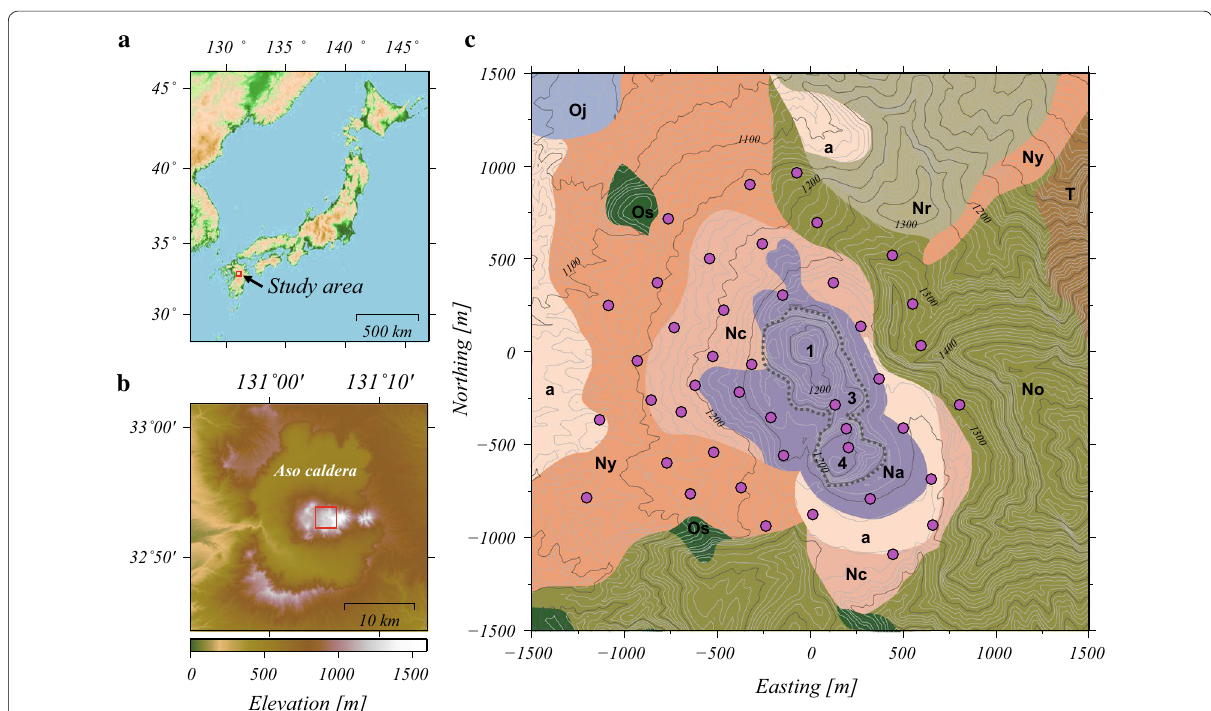
Fig. 1 Location maps of Aso volcano and the AMT survey area. a Location map of Aso volcano in Japan. The red rectangle corresponds to the area shown in ( b ). b Elevation map of the entire area of Aso volcano. The study area is indicated by the red rectangle, corresponding to the area shown in ( c ). c Geological map of the study area (after Ono and Watanabe 1985) showing the distribution of AMT sites (purple circles) used in this study. The lithologies are as follows (from youngest to oldest). a: air-fall ash; Na: youngest pyroclastic cone of Nakadake; Ny (lava flow) and Nc (tuff cone): young volcanic edifice of Nakadake; No: old volcanic edifice of Nakadake; Oj: Ojodake volcano; T: Takadake volcano; Nr: Naraodake volcano; and Os: older small volcanoes. The gray dotted line represents the outline of the Nakadake crater system, and the numbers (1, 3, and 4) within it indicate the locations of the first, third, and fourth craters, respectively. The thin gray lines and thick gray lines represent elevations at 10-m and 50-m intervals,